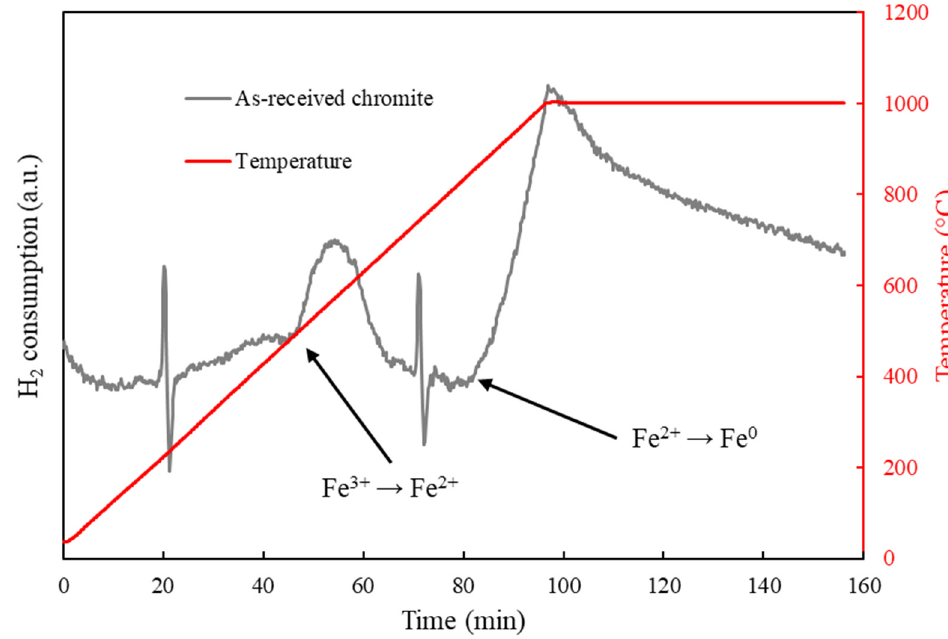
Figure 3. Temperature programmed reduction (TPR) profile of as-received chromite reduced in a 10 vol.% H 2 /N 2 atmosphere at 1000 °C for 60 min.